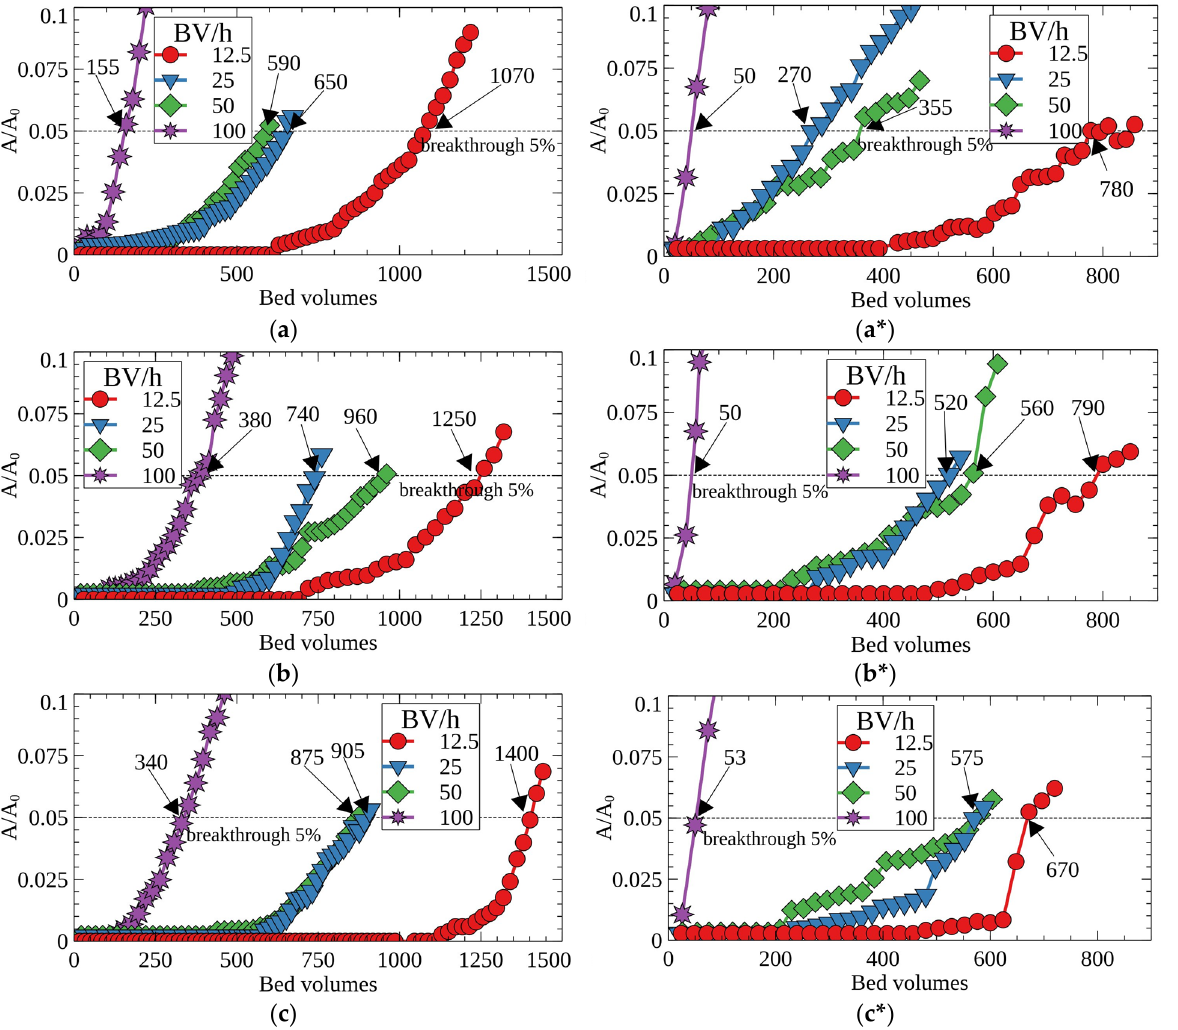
Figure 6. Breakthrough curves of Cs-137 sorption from the model solution No. 2 under dynamic conditions at different flow rates; ( a ) RFR, ( b ) RFR-Ca and ( c ) RFR-T, ( a – c )—grain size 0.1–0.2 mm, ( a* – c* )—grain size 0.2–0.5 mm.